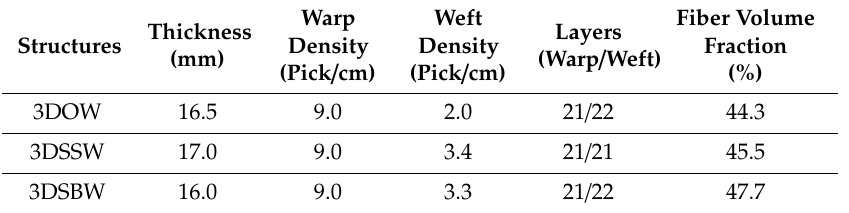
Table 1. The specifications of 3D woven